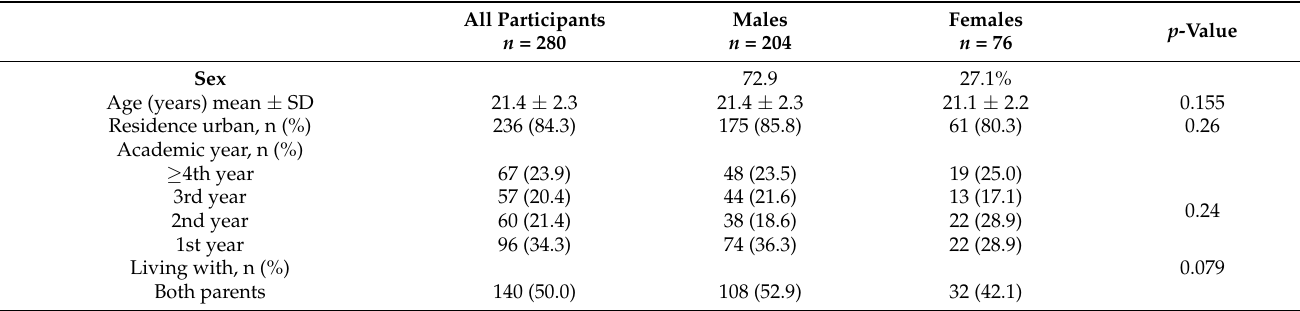
Table 1. Characterization of the